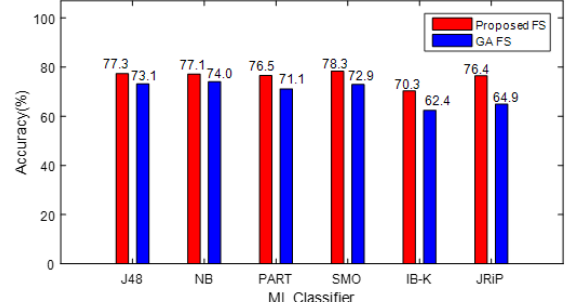
Figure 12. Yelp Dataset Accuracy Comparison